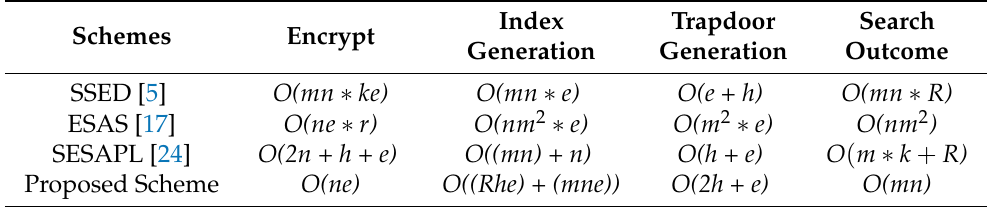
Table 2. Complexity Comparative